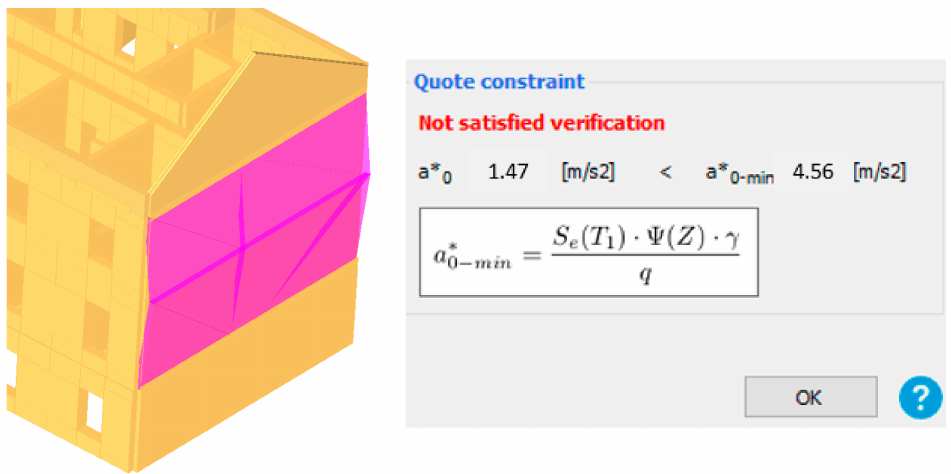
Figure 24. Local mechanism LM3 (Southern walls of the 2nd and 3rd